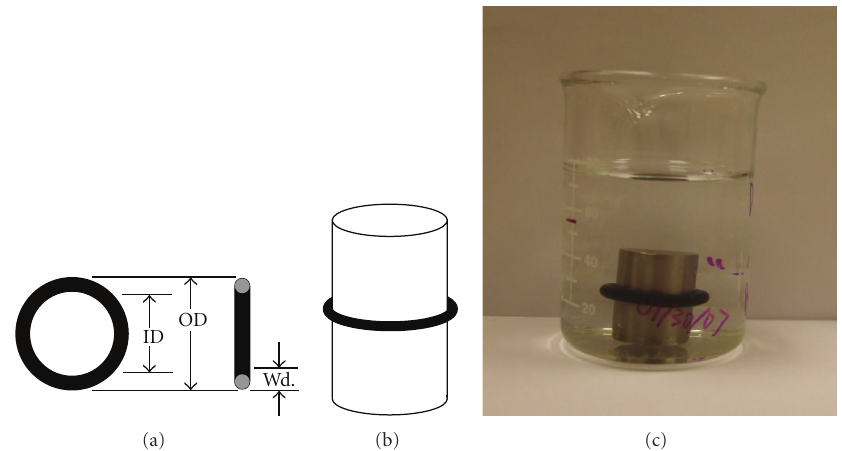
Figure 3: (a) Round O-ring with cross-section shown; (b) the O-ring mounted on a cylindrical metal sample; and (c) the metal sample, fitted with an O-ring and immersed in the artificial seawater solution.